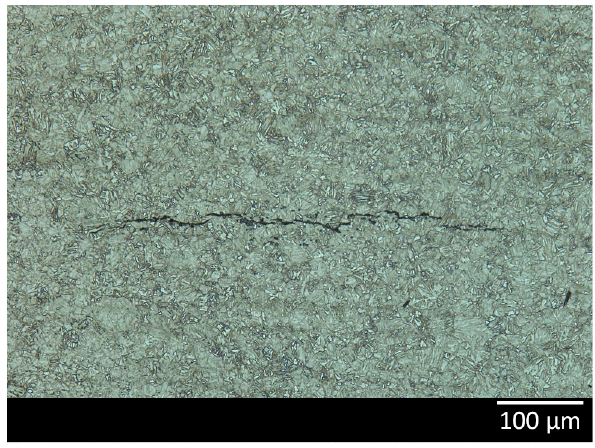
Figure 9. Optical microscope image of a hydrogen induced crack present in the low Mo material after 28 days of testing.